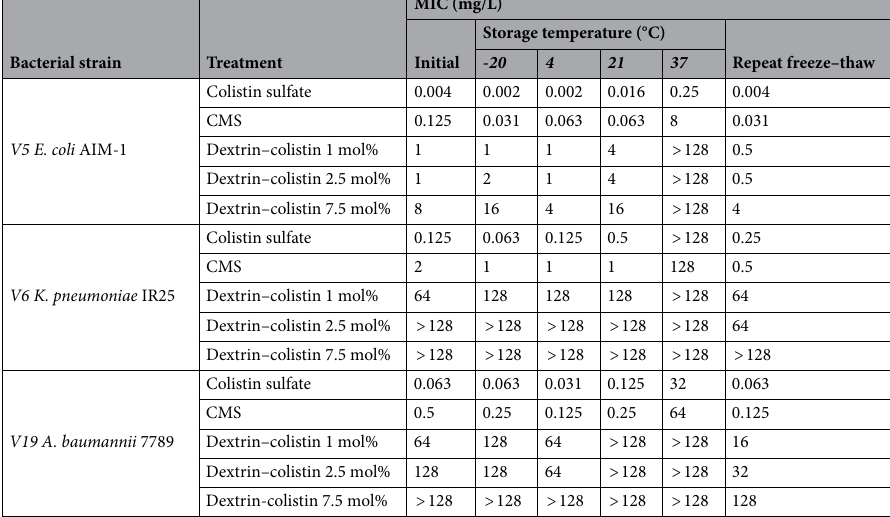
Table 1. Antimicrobial activity of colistin sulfate, CMS and dextrin–colistin conjugates following storage at -20, 4, 21 or 37 °C for 12 months or exposed to weekly freeze-thawing for 5 weeks, measured by MIC assay. Data is expressed as mode ( n = 3). MIC value represents equivalent colistin concentration of